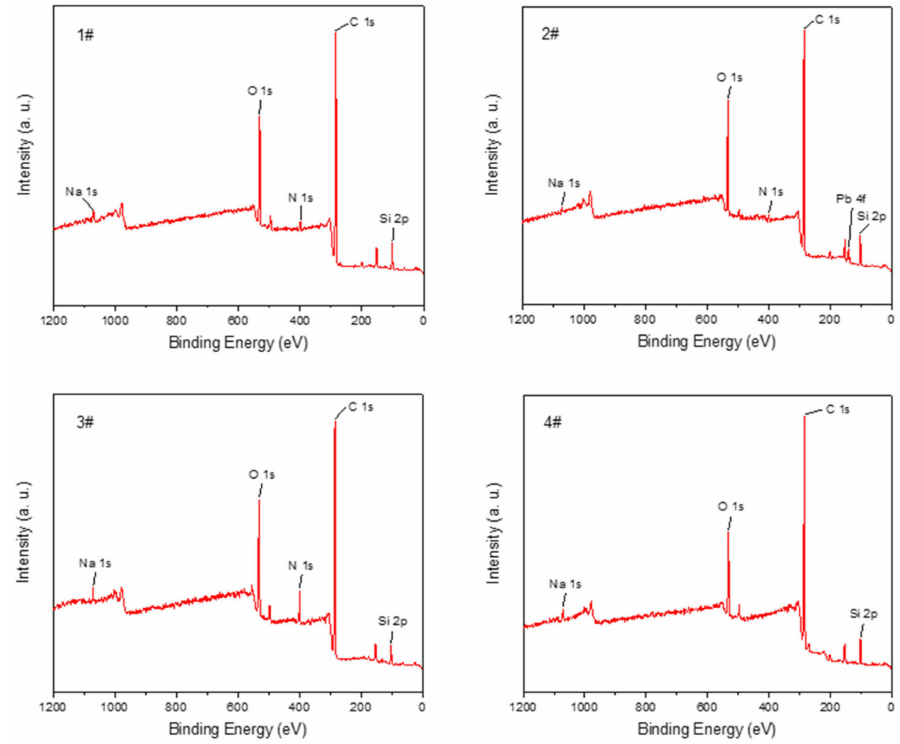
Figure 15. The XPS survey scans of different surfaces. The section of the motor before the ignition 360 test: ( 1# ) the longitudinal section, ( 2# ) inner wall section, ( 3# ) transverse section. ( 4# ) is the inner wall section of the motor before the ignition